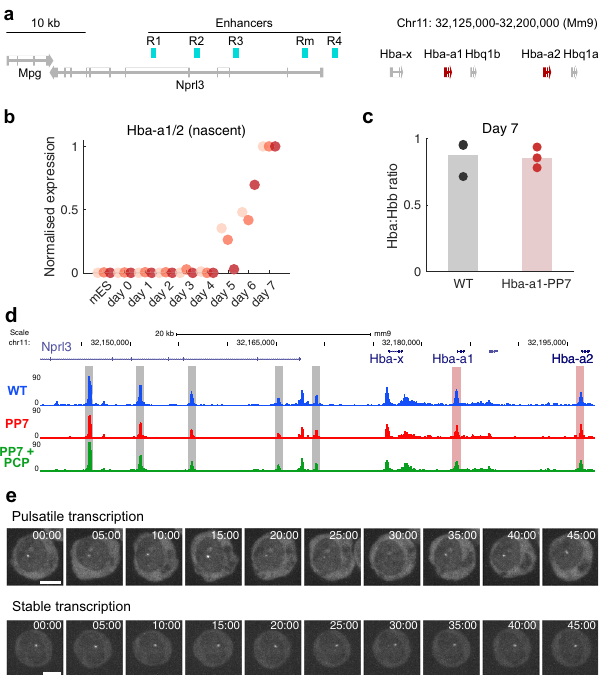
Fig. 2 | Visualising α -globin transcriptiondynamicsinerythroid cellsusingthe PP7 imaging system. a Schematic of mouse α -globin locus on chromosome 11. α - globin genes are highlighted in red, enhancers in cyan. b RT-qPCR time course of nascent α -globin mRNA during embryoid body (EB) differentiation. Data are nor- malised to Rn18s and then within differentiation time course. n =3 biologically independentsamplesateachtimepoint.Coloursrepresentindividualexperiments. c RT-qPCR quantitation of α -globin mRNA abundance relative to β -globin at day 7 of differentiation. n =3 biologically independent samples. d ATAC-seq in WT, Hba- a1 -PP7(PP7)and Hba-a1 -PP7+PCP-GFP(PP7+PCP)cellsatthe α -globinlocus.Grey shaded regions show known enhancers, red shaded regions show α -globin gene promoters. e Representative examples of nascent Hba-a1 -PP7 transcription over time showing pulsatile or more stable gene activity in individual erythroblasts derived from day 6 EBs. Frames are a maximum projection of fi ve z-slices around transcription spot from within the full image stack. Time in minutes. Scale=5 μ detected in differentiated cells containing PP7 loops integrated into Hba-a1 , and not in WT control cells (Supplementary Fig. 4A). These